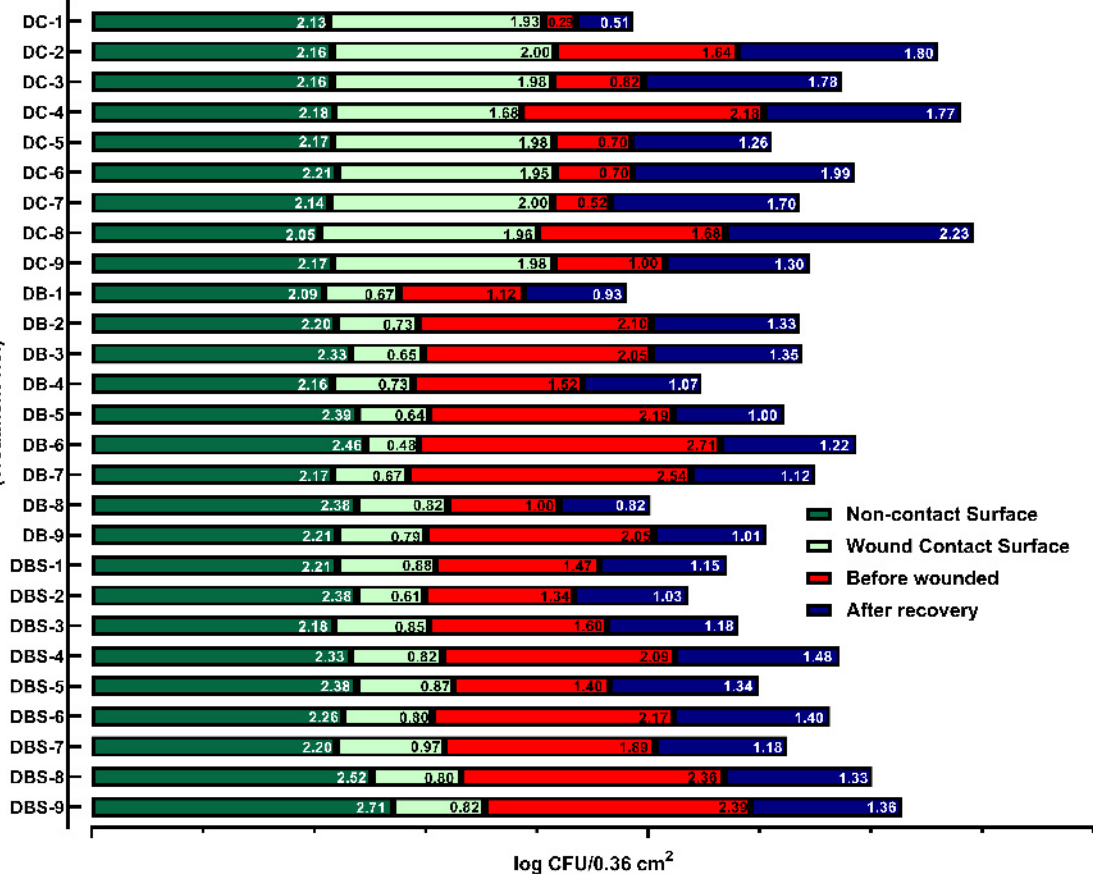
Figure 6. Effects of different dressing treatments on wound bacterial counts in diabetic mice. The wounds of mice covered with gauze (DC), bacterial cellulose (DB), and Suile ointment combined with bacterial cellulose (DBS) were sampled with cotton swabs to calculate the bacterial counts; numbers one to nine represent the mice number. Furthermore, the dressing was collected after the sacrifice, and the bacterial counts were determined after 48 h. The units in the figure are in log CFU/0.36 cm 2 . ( n = 21 with BKS.Cg-Dock7m +/+ Leprdb/JNarl mice).